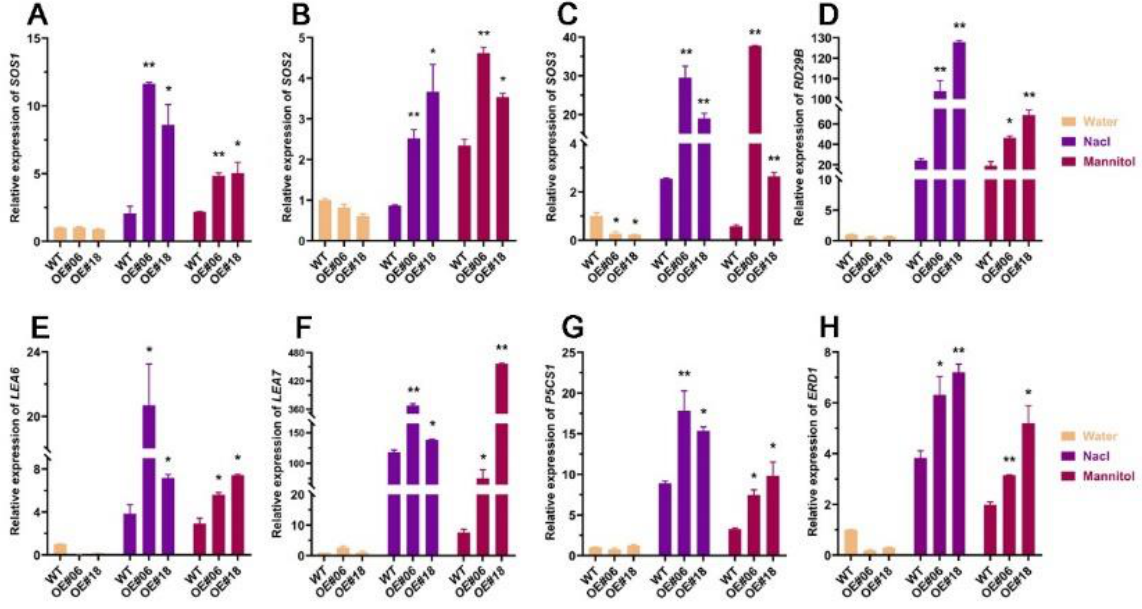
Figure 7. FtbZIP12 promotes the expression of downstream stress genes. Untreated wild-type plants were considered a control. Three independent experiments were conducted, each of which involved at least three plants. The error bars denote ± SDs; values are shown as means ± SD. * p < 0.05; ** p < 0.01.